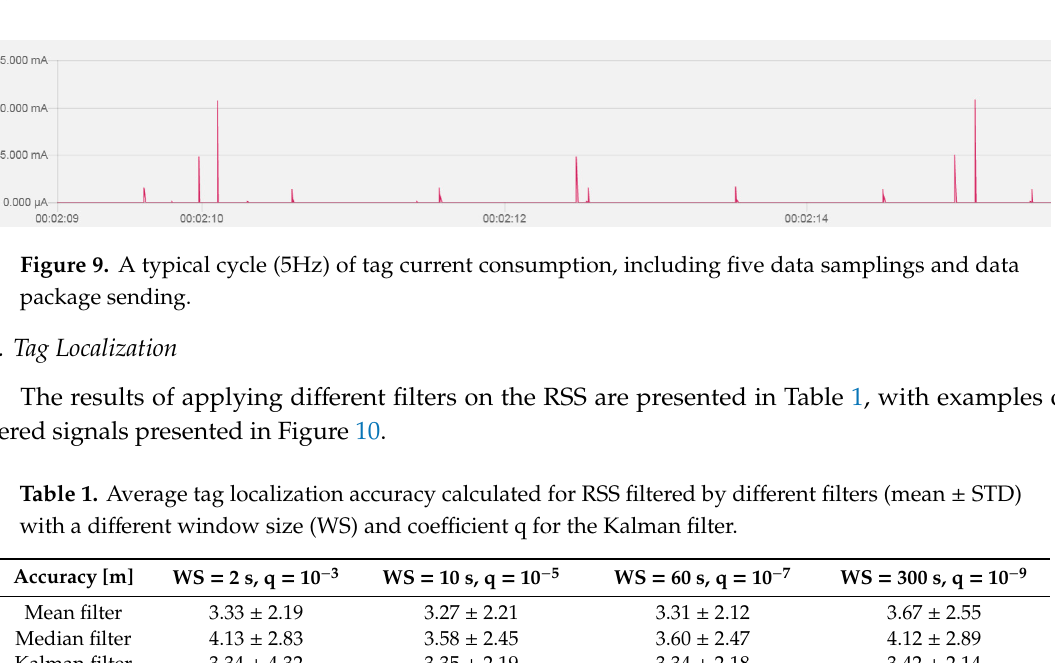
Figure 8. Results of the RSS-orientation experiment in the open space ( a ) and in the barn ( b ). The solid lines represent the average for each value of θ , and the boxplots represent the RSS deviation of the line with the corresponding color.